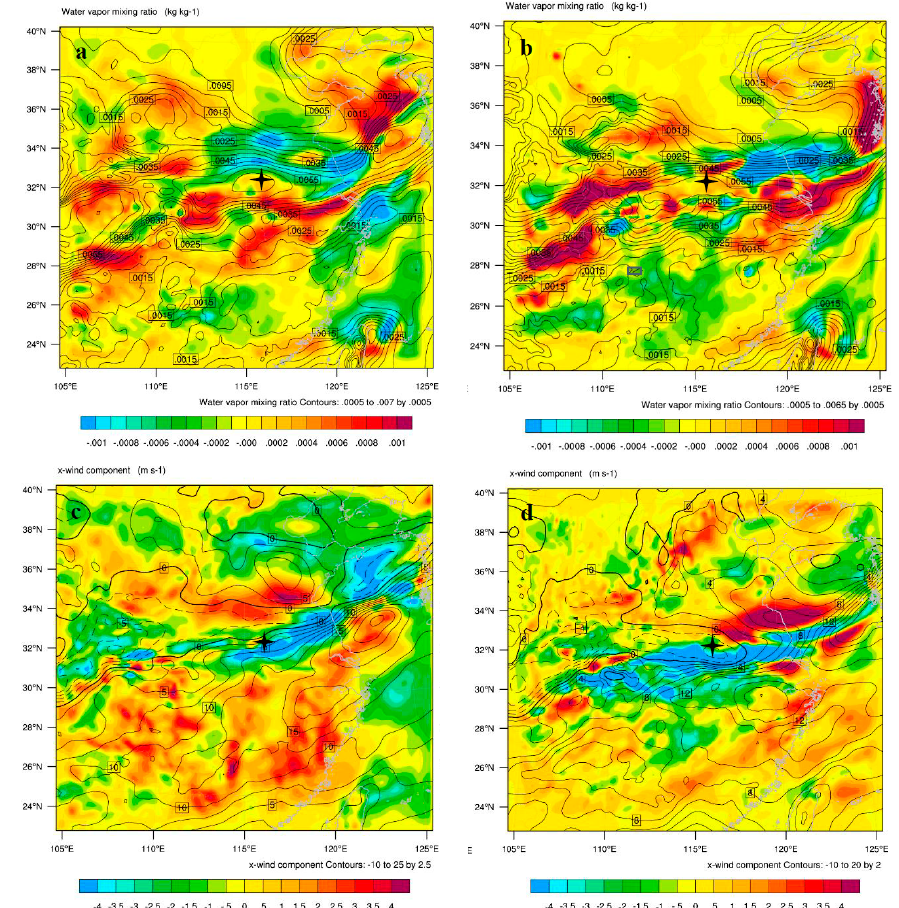
Figure 5. Analysis increments of water vapor mixing ration ( a , b ) (shaded; kg / kg) and zonal wind ( c , d ) (shaded; m / s) at the beginning of the assimilation window ( a , c ) and at the end of the assimilation window ( b , d ) of the single rainfall observation test. The solid black lines are contours of the corresponding background. The location of the single rainfall observation is marked out by the black star.